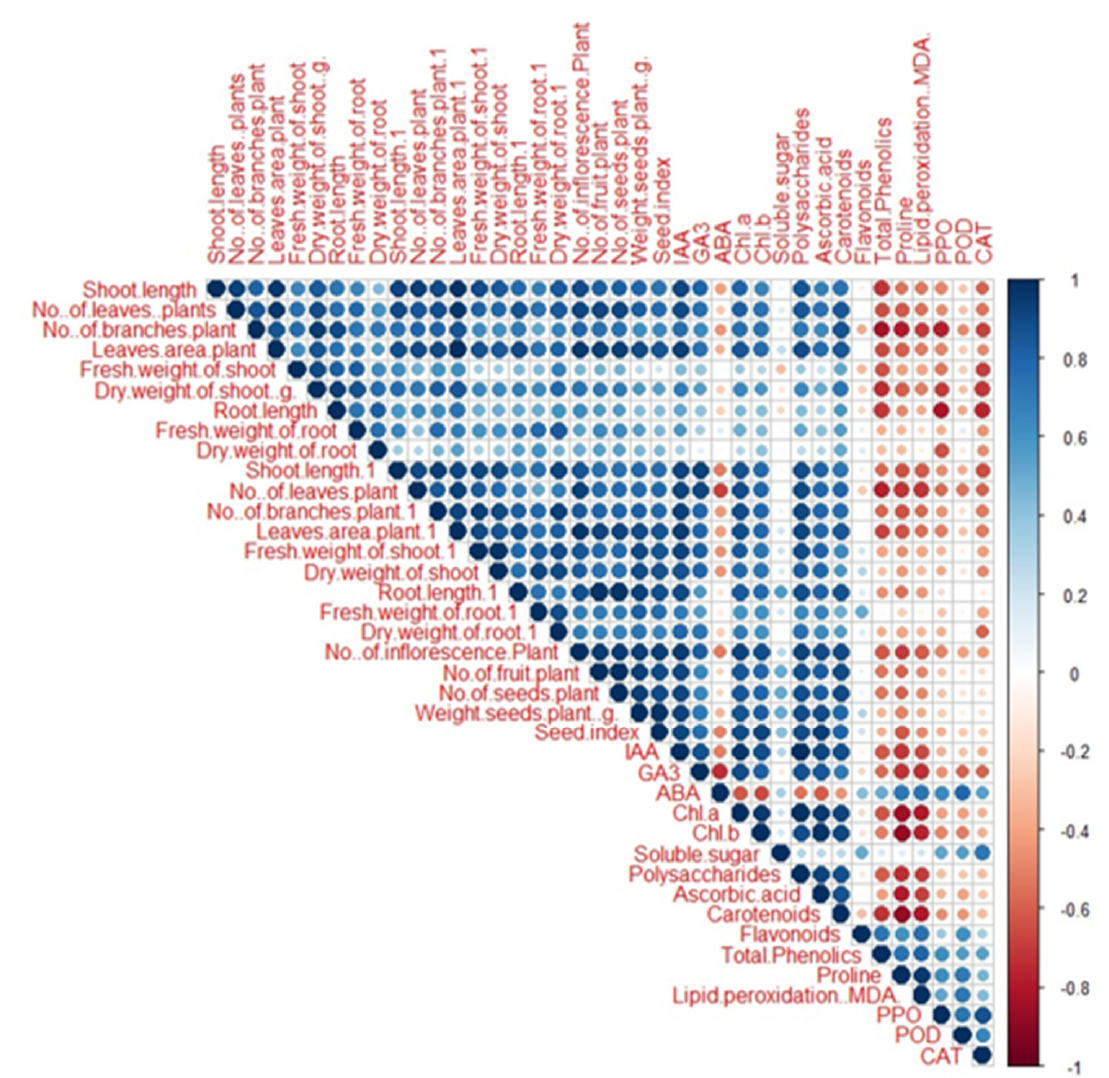
Figure 1. Correlogram based on the correlation coefficients based on morphological and metabolic measurements. The blue colour indicates the positive correlation between measurements, whereas the red colour assumes the negative one.